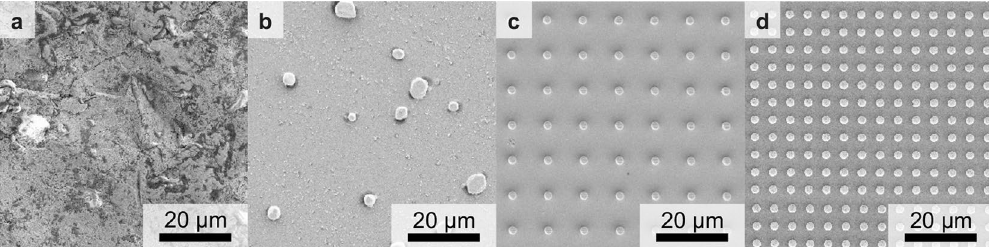
Figure 2. Top-view electron micrographs of four of the five investigated samples. ( a ) Sample #1 is a sandblasted copper surface. ( b ) Sample #2 is a glass substrate with randomly distributed micrometer-sized gold grains on top. Sample #3 (not depicted) is a glass substrate with a square array of polymer markers with period a on top, fabricated by 3D laser printing. Without metal coating, this sample cannot easily be imaged by electron microscopy. ( c ) Sample #4 is as sample #3, but coated with a 54 nm thin film of gold. ( d ) Sample #5 is as sample 5 µ m #4, but with a period of a =